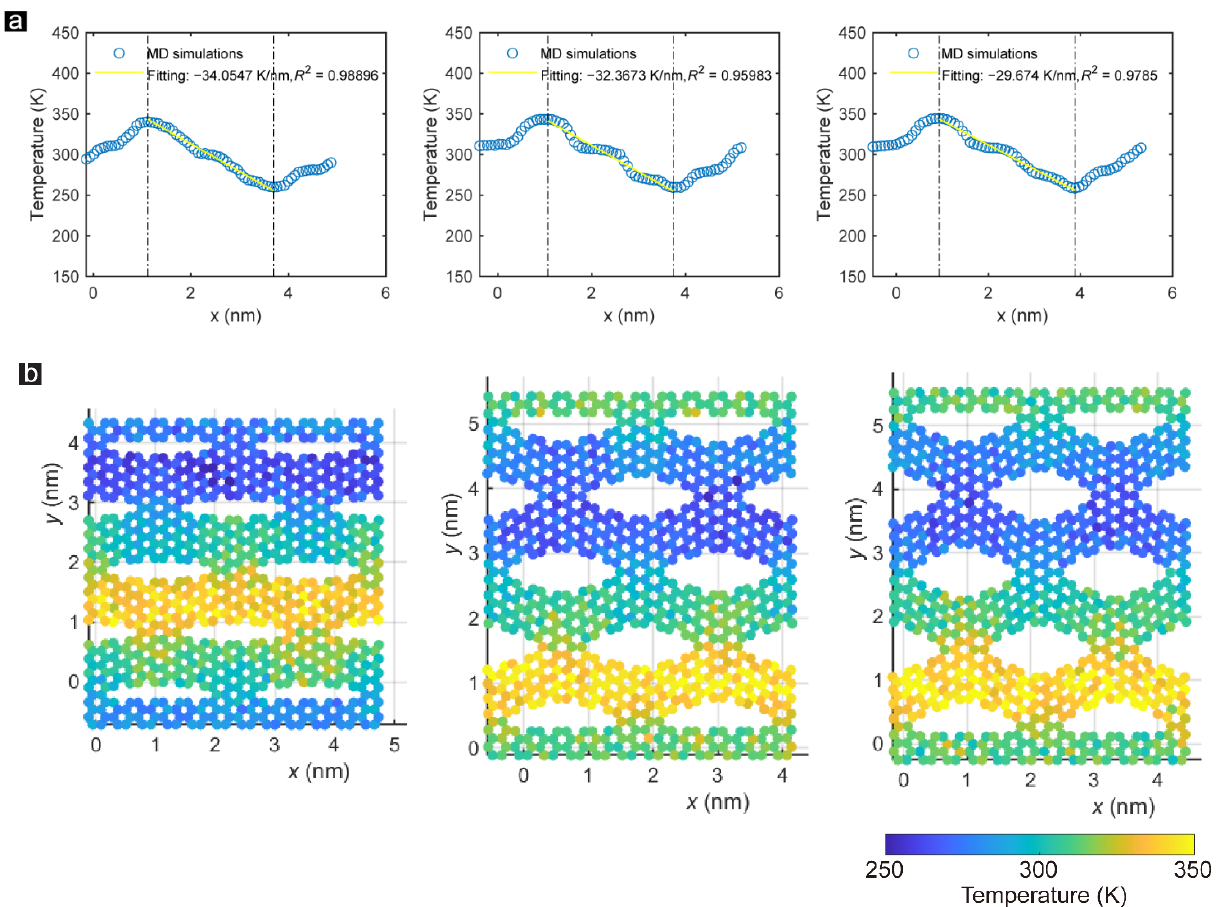
Figure 8. ( a ) Time-averaged temperature distribution of each atom along the direction perpendicular to the armchair-incised GK incisions under 5%, 15%, and 20% strain. ( b ) Snapshots of the temperature distribution of Samples AC_3_1_5%, AC_3_1_15%, and AC_3_1_20% after one nanosecond of heat conduction.